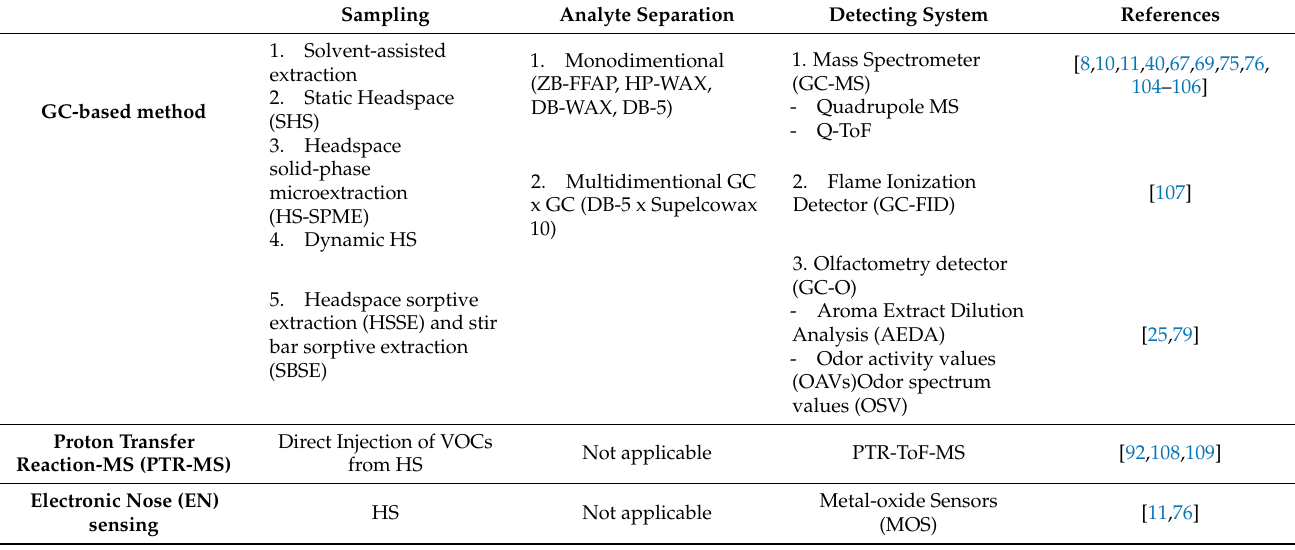
Table 4. Major analytical techniques used for the determination of volatile compounds in Espresso